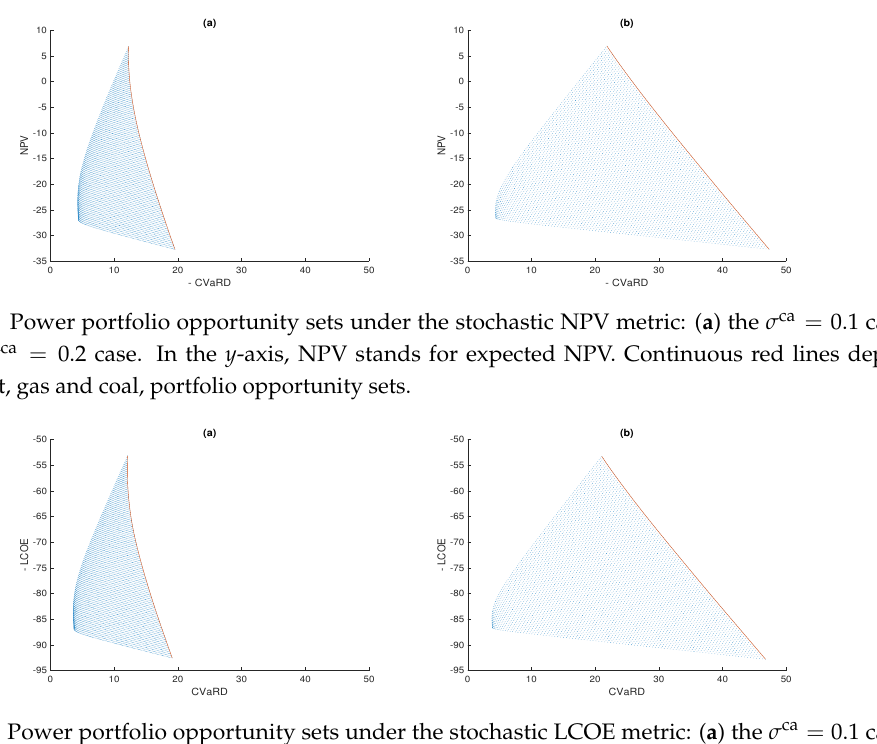
Figure 8. Power portfolio opportunity sets under the stochastic LCOE metric: ( a ) the σ ca = 0.1 case; ( b ) the σ ca = 0.2 case. In the y -axis, LCOE stands for expected LCOE. Continuous red lines depict two-asset, gas and coal, portfolio opportunity sets.